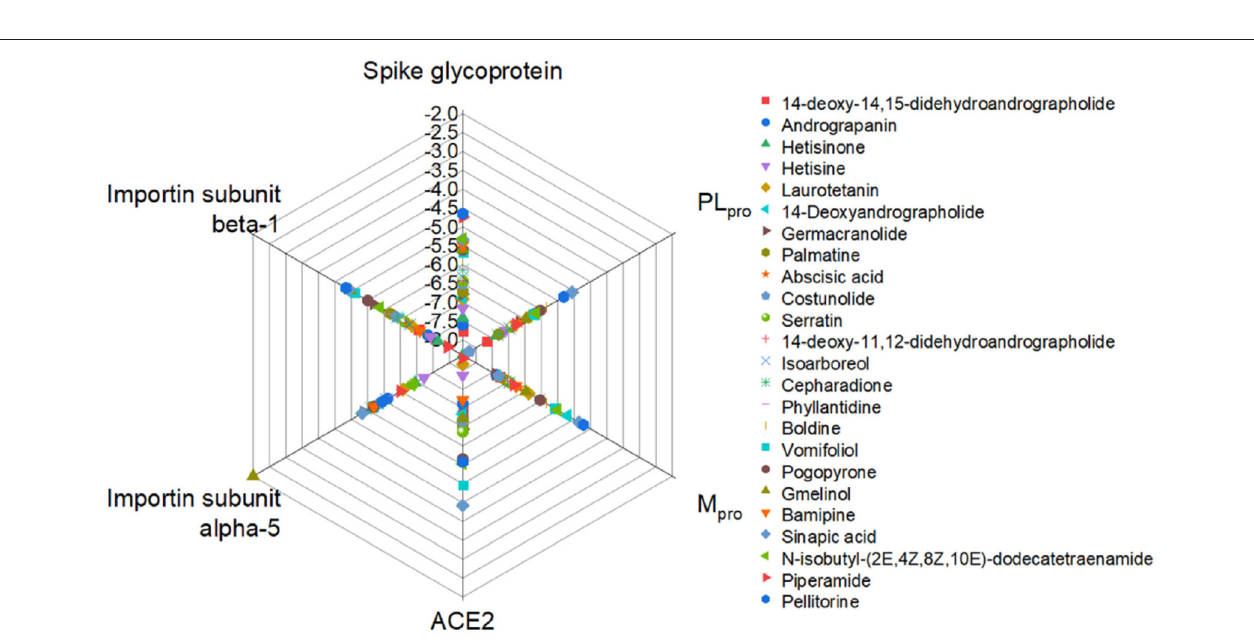
FIGURE 4 | Relative binding energies of phytochemicals with the viral and host proteins (78).